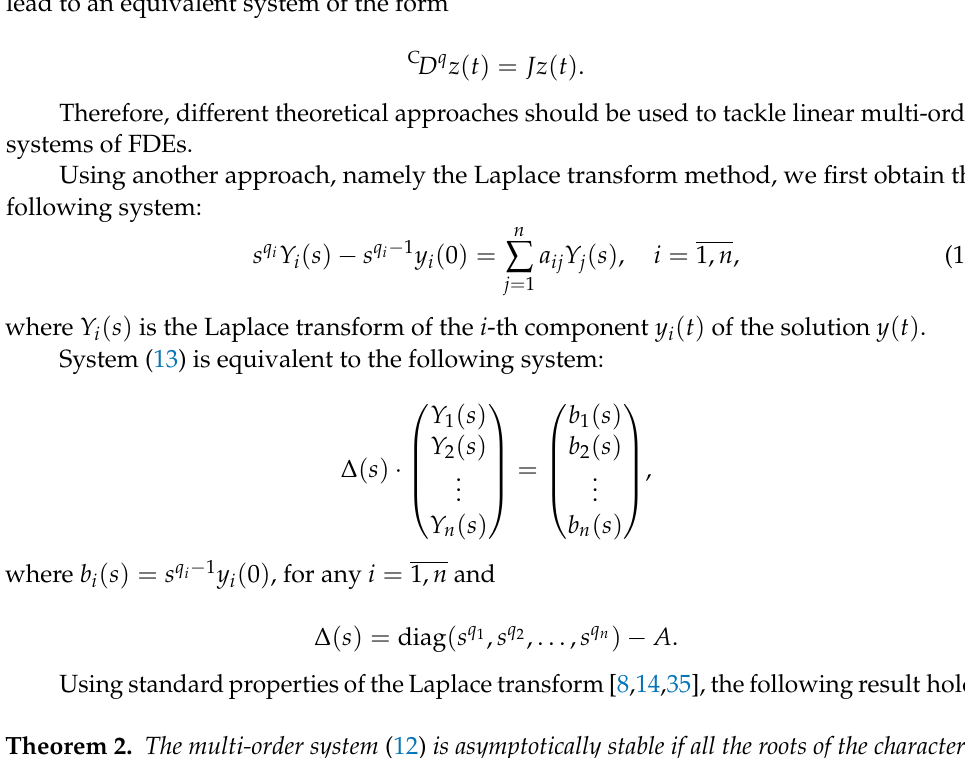
3 ( left plot) and